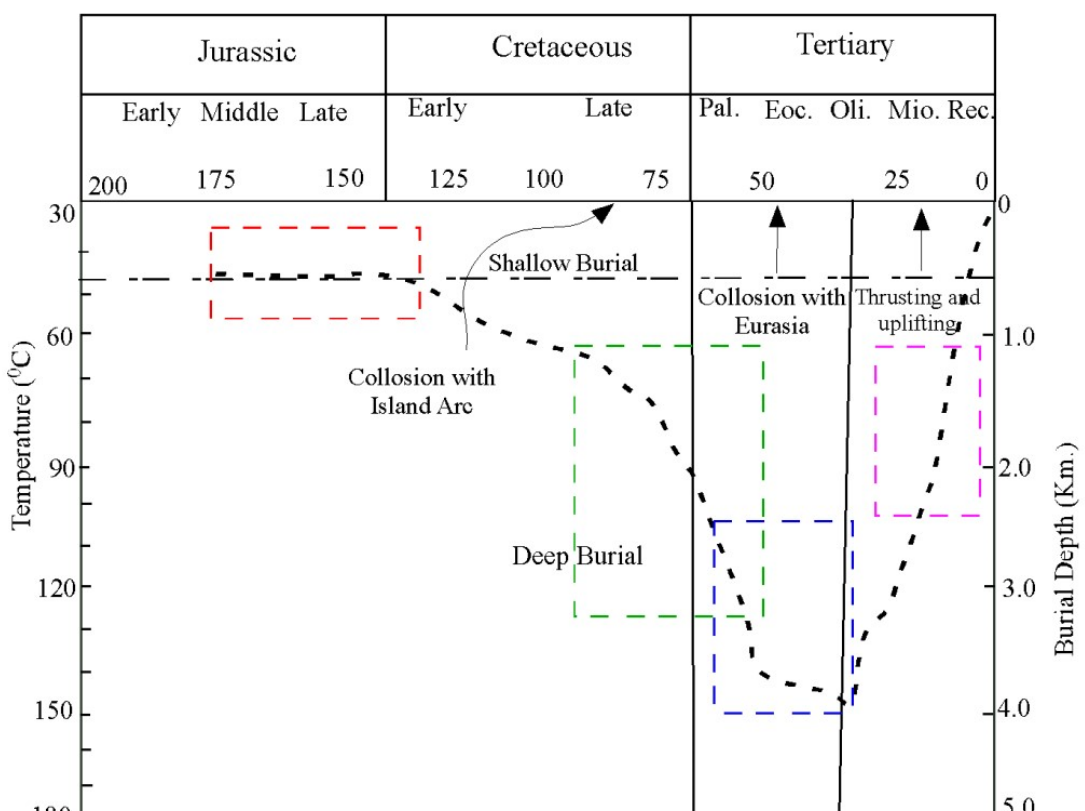
Figure 12. The burial history plot of the Jurassic succession of the Indus basin was modified after [19]). The curve is constructed by assuming a surface temperature of 30 °C and a geothermal gradient of 30 °C. The presumable diagenetic processes are marked with dotted rectangles. Red: matrix dolomite (RD-I), Green: replacive dolomite (RD-II), blue: saddle dolomite (SD), Pink: fracture-filling calcite (CC).